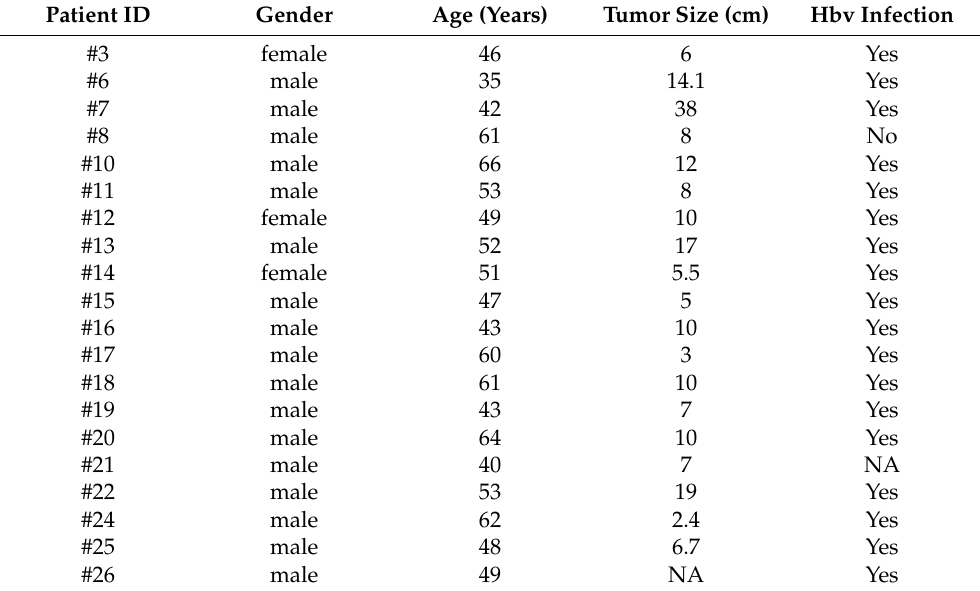
Table 1. The clinicopathological characteristics of patients used in this